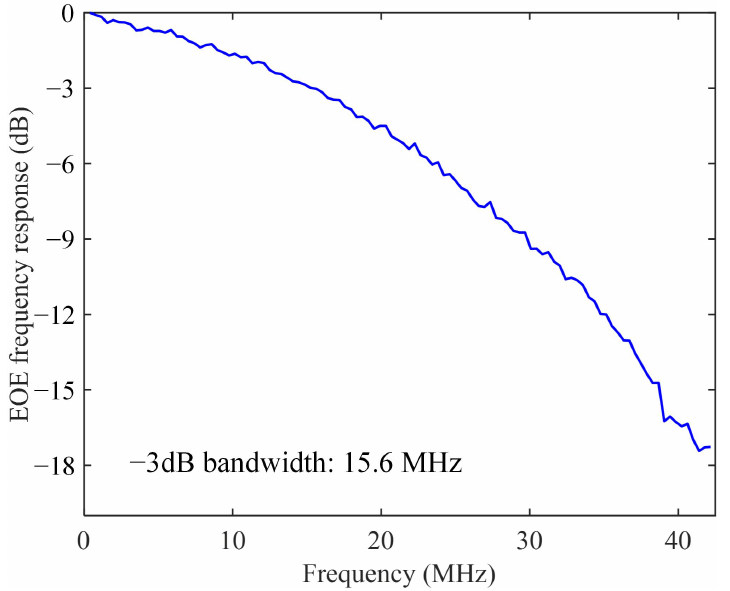
Figure 6. EOE frequency response of the experimental VLC